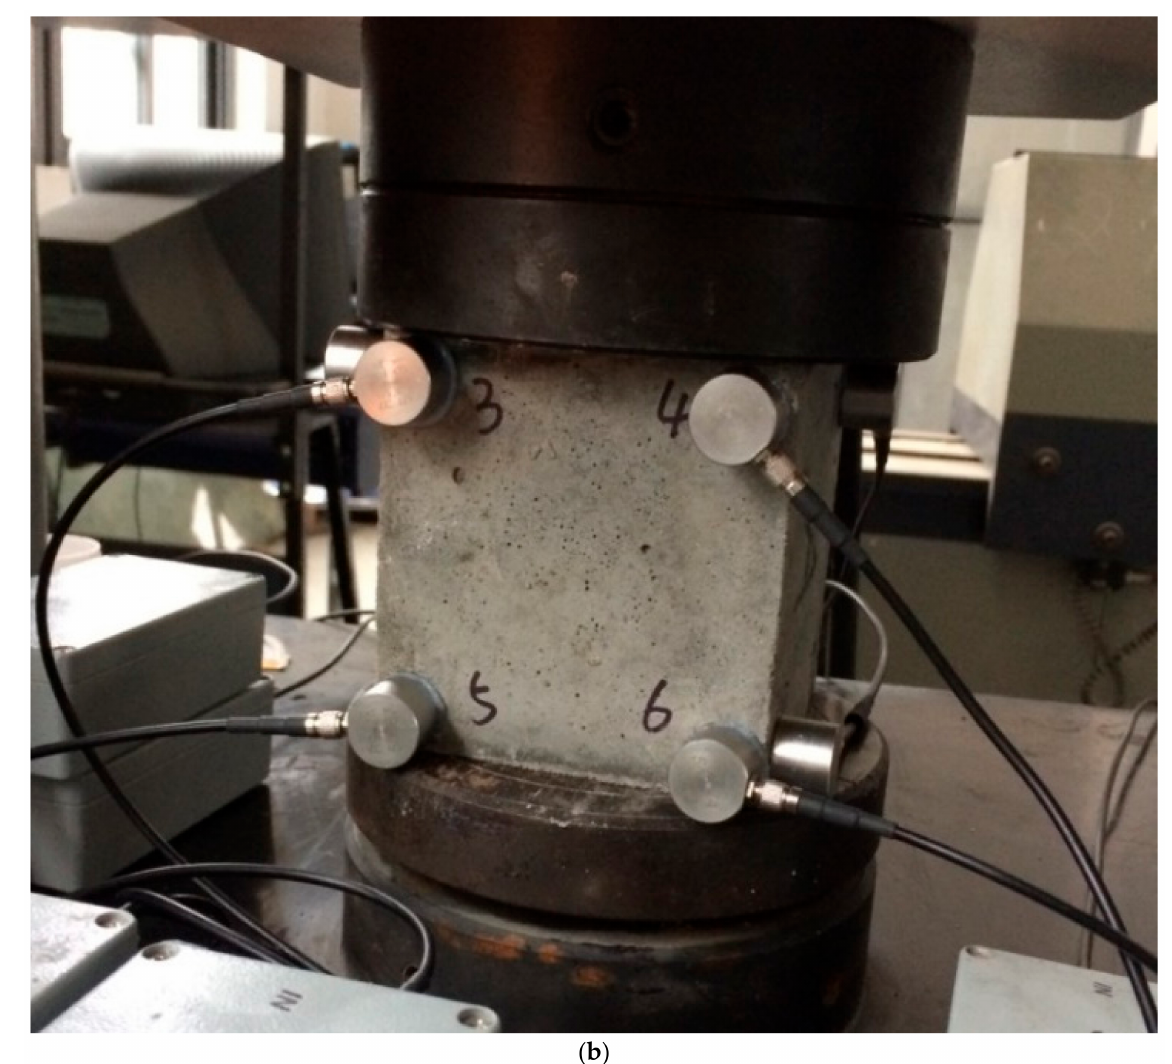
Figure 2. The layout of sensors on a concrete surface. ( a ) The configuration of 8 sensors on a concrete surface. ( b ) The photo of the testing